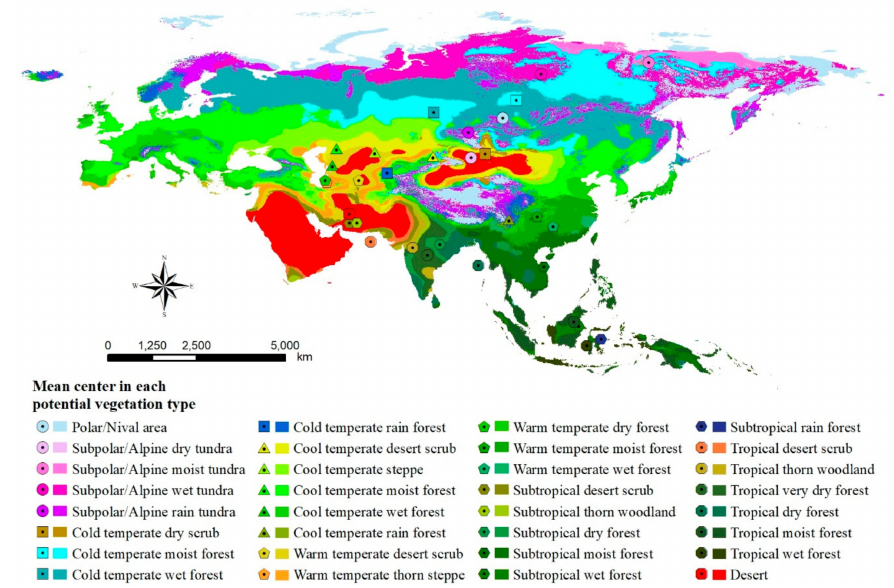
Figure 2. Distribution of the mean centers of potential vegetation ecosystems in Eurasia in the T0